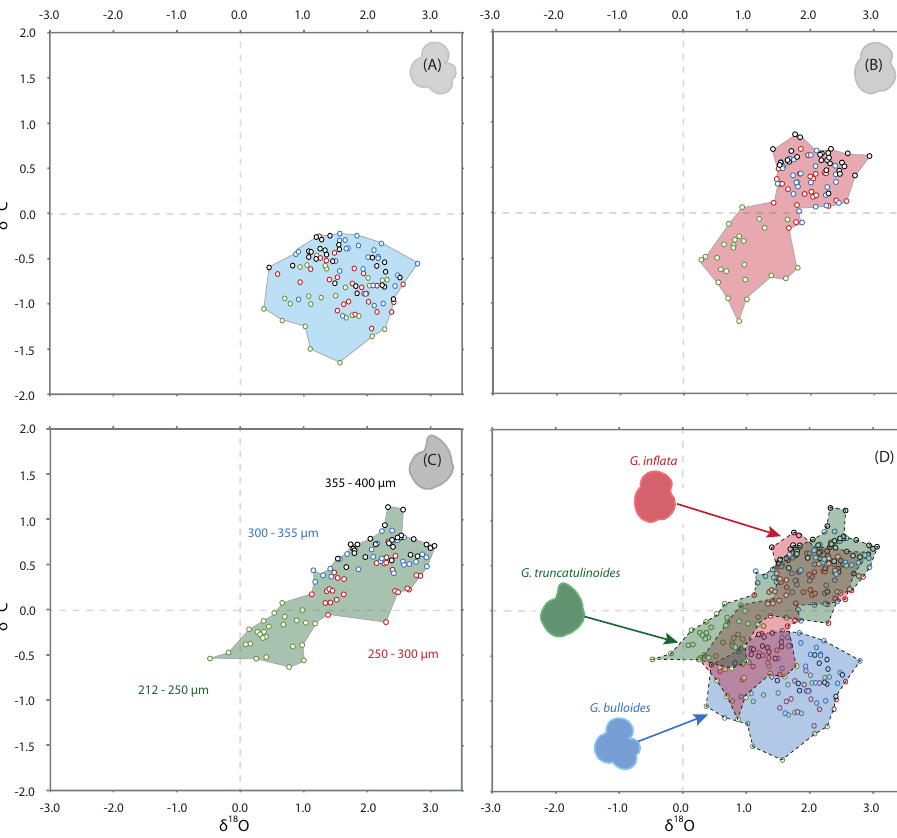
Figure 9. Cross-plot of oxygen and carbon values. Cross-plot between mean δ 18 O and δ 13 C for all size fractions of (a) G. bulloides , (b) G. inflata , (c) G. truncatulinoides and (d) all species. For (a) – (c) , symbol colour represents size fraction as per Figs. 5 and 8: 212–250 (green), 250–300 (red), 300–355 (blue) and 355–400µm